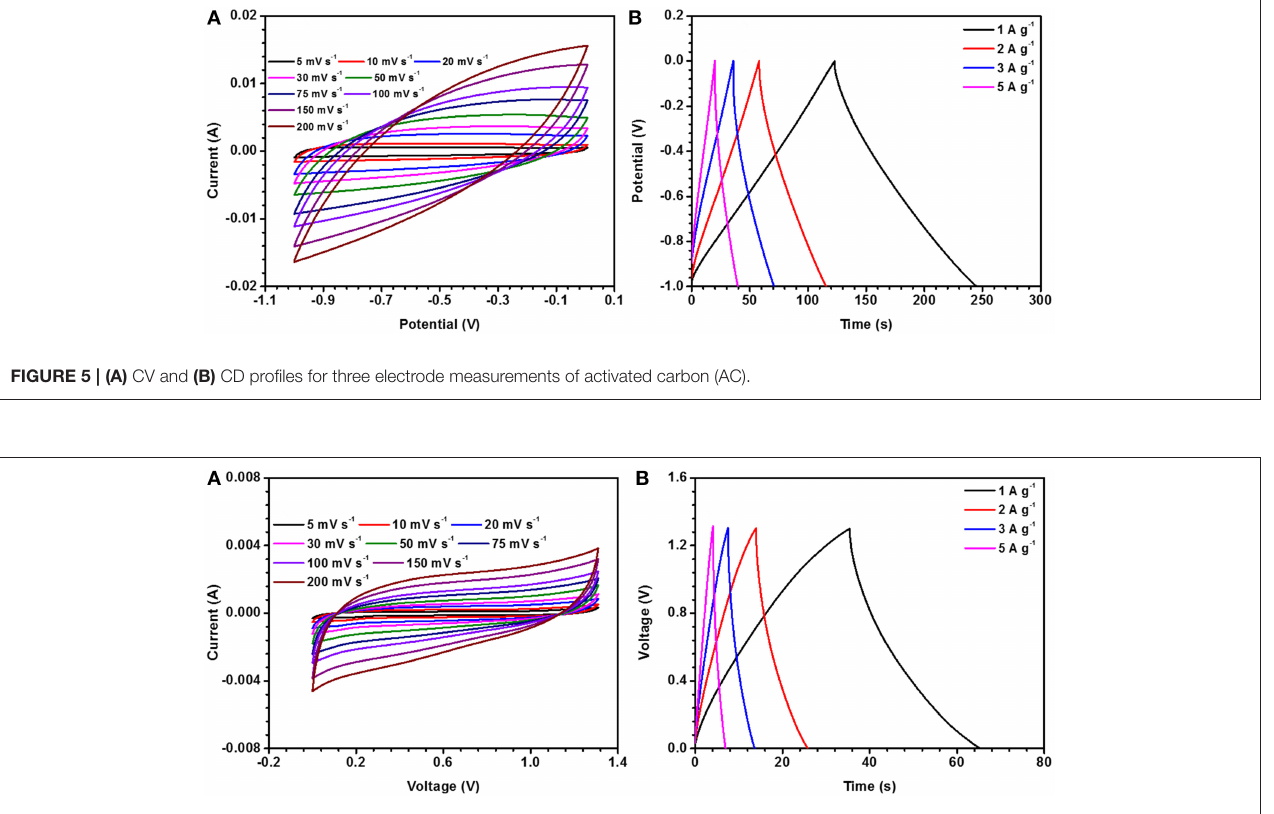
FIGURE 6 | (A) CV and (B) CD profiles of NaFePO 4 //AC device at room temperature (25 ◦ C).